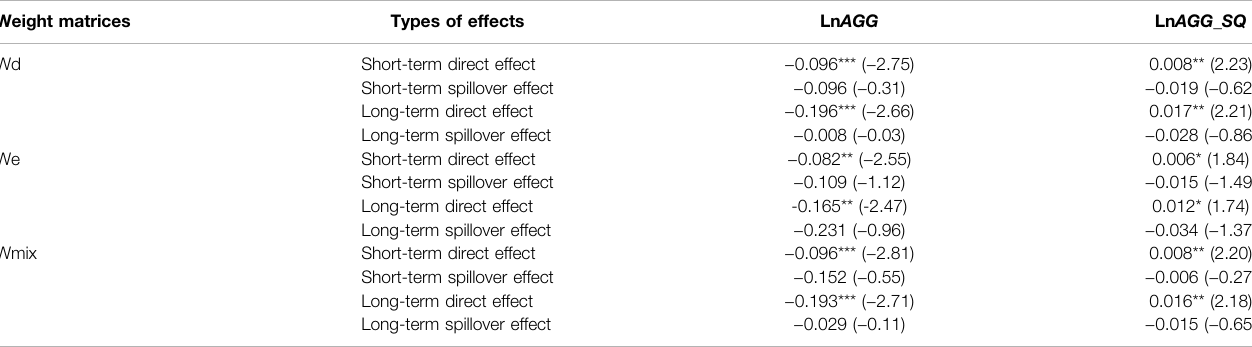
TABLE 5 | The estimation result of the effect